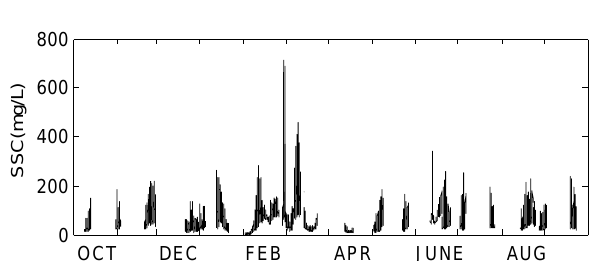
Figure 2. Relative errors of first four PCs (ISSA: red line; SSAM: black line).